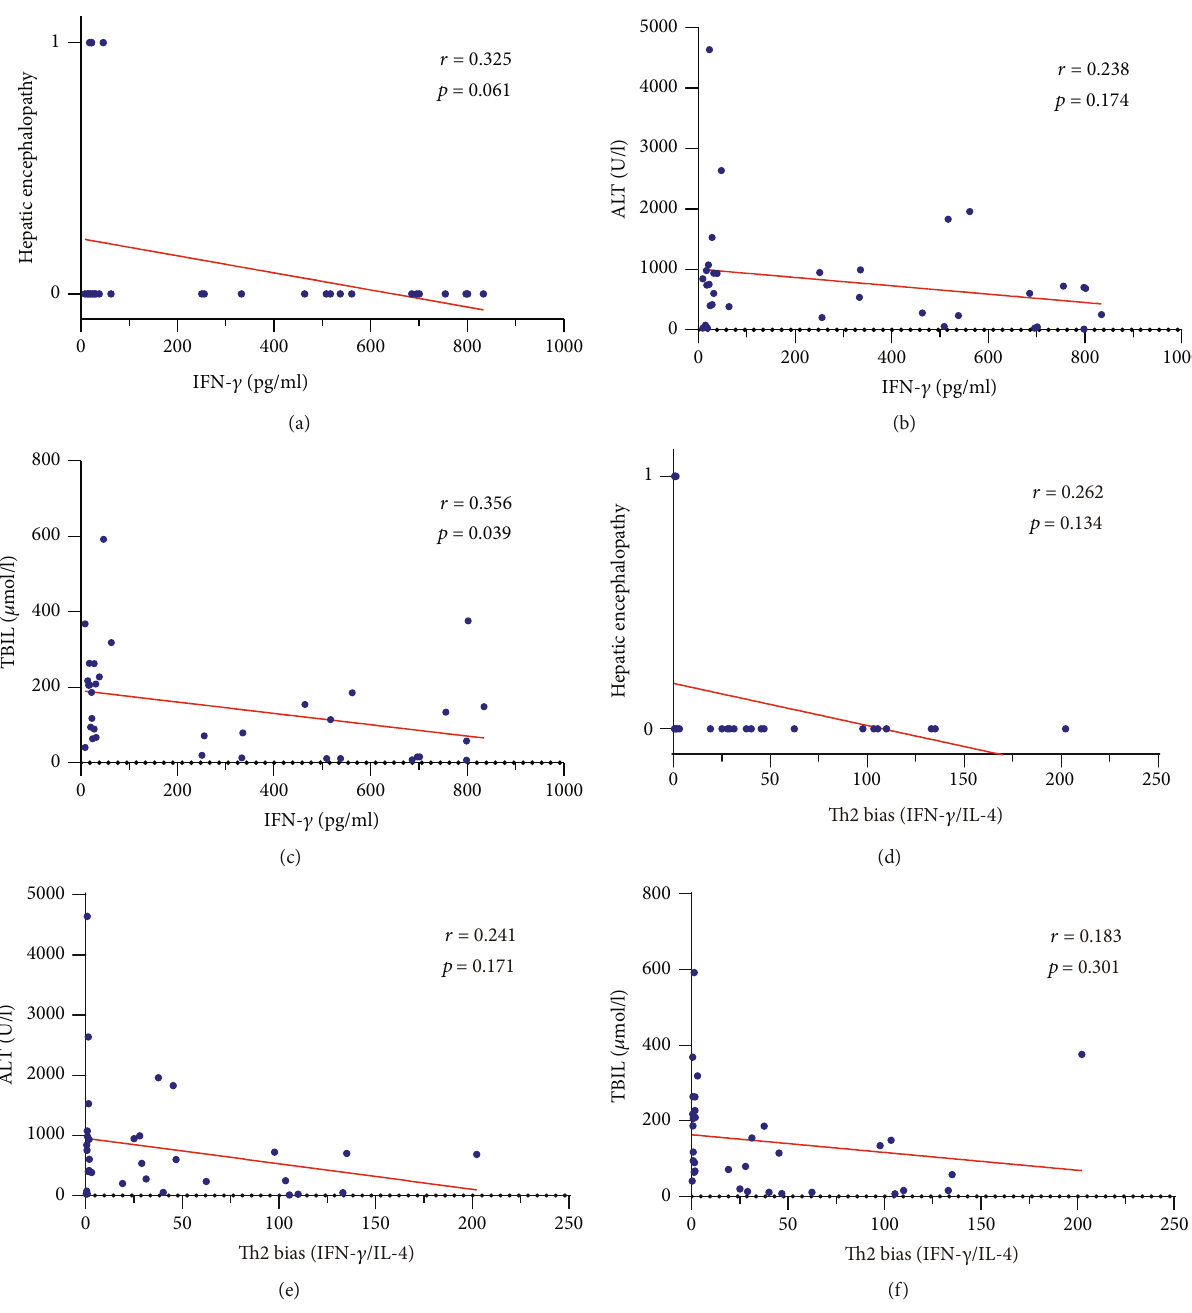
Figure 3: Correlation of ALT, TBIL, and severity of hepatic encephalopathy with Th2 bias and IFN- γ . (a – c) Correlation of severity of hepatic encephalopathy, ALT, and TBIL with the level of IFN- γ . (d – f) Correlation of severity of hepatic encephalopathy, ALT, and TBIL with Th2